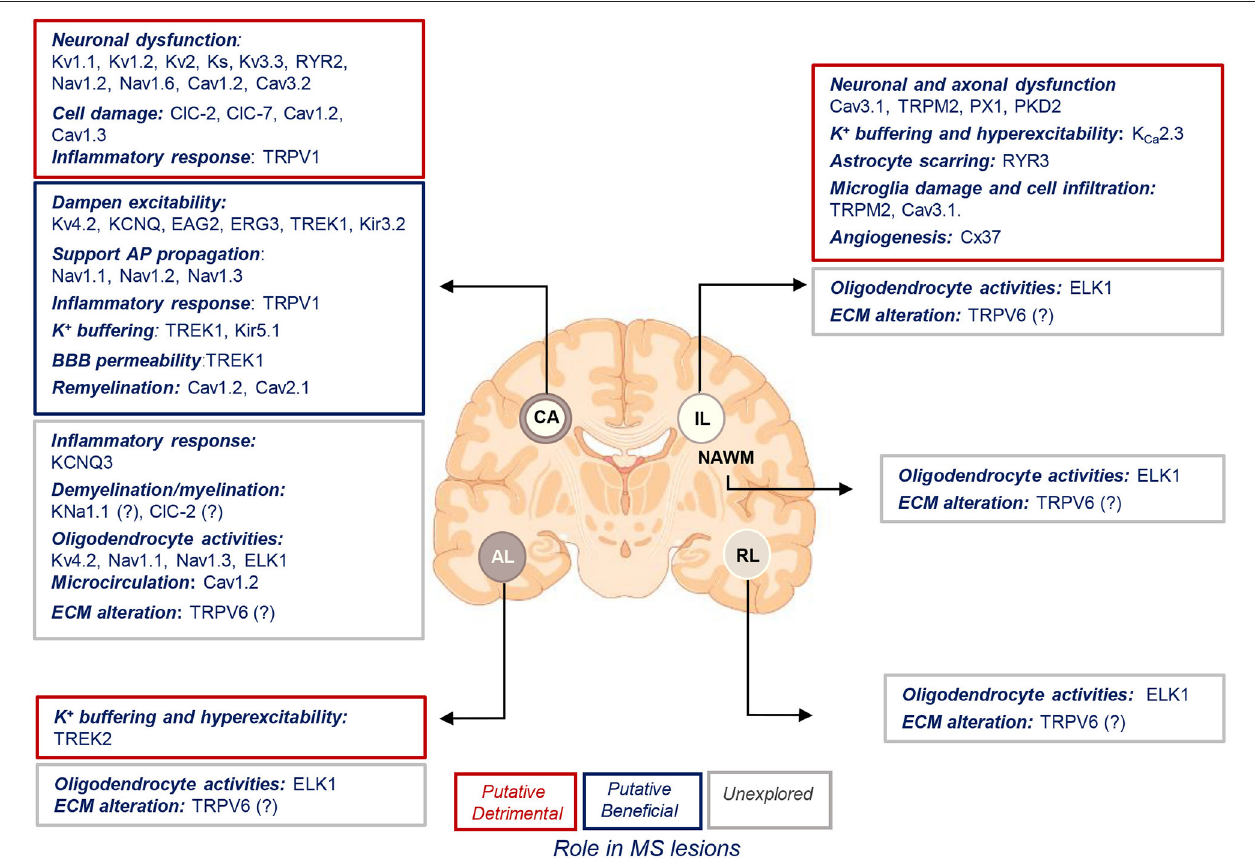
FIGURE 4 | Putative roles of ion channels encoded by uniquely dysregulated genes in SPMS lesions. Schematic illustration of the putative detrimental (red box), putative beneficial (blue box), and unexplored (gray box) functional roles of ion channel encoded by the uniquely dysregulated genes in active (AL), chronic active (CA), inactive (IL), and remyelinating (RL) lesions, and normal-appearing white matter (NAWM) of SPMS brain. Source icon is from Biorender.com.